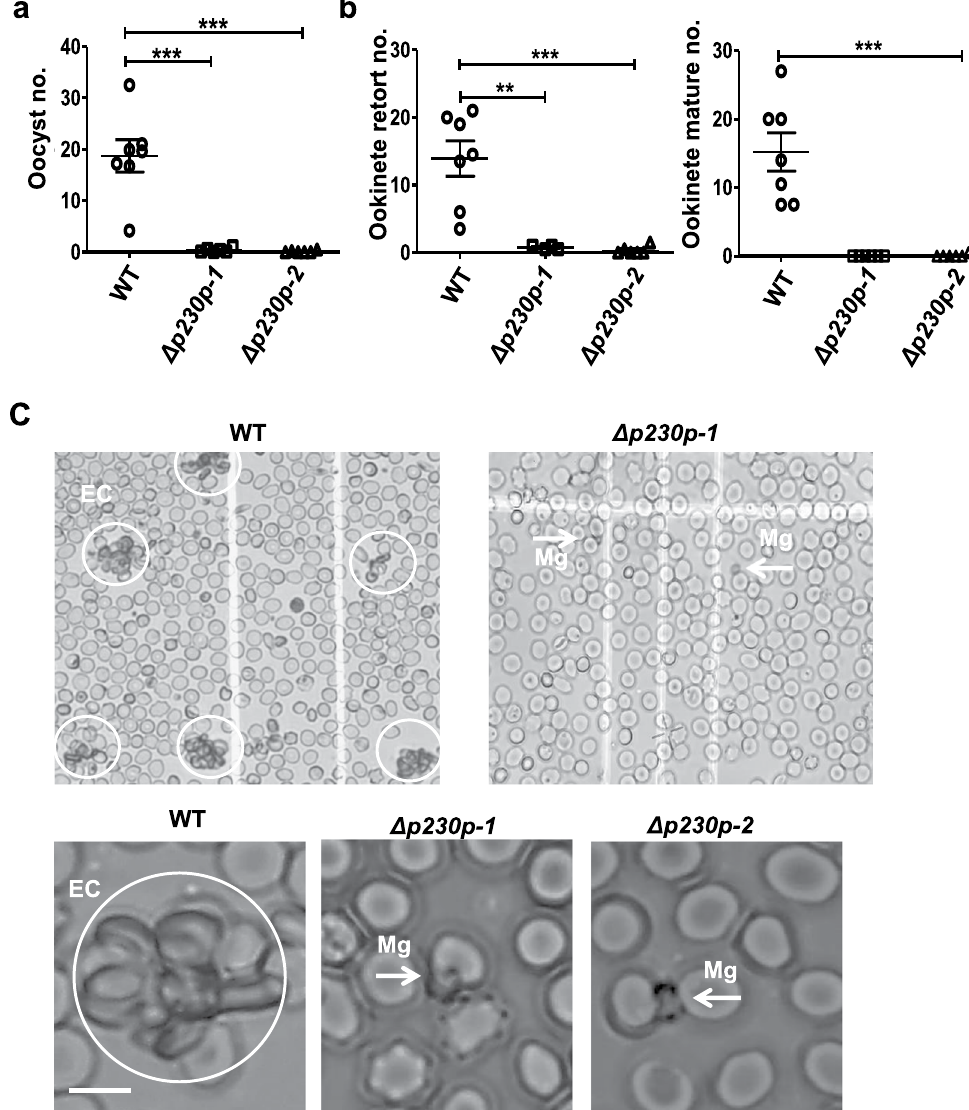
Figure 2. Mosquito development (ookinete and oocyst formation) and in vitro formation of exflagellation centres of Pf Δ p230p parasites. ( a ) Mean oocyst numbers in A . stephensi mosquitoes at day 8 after feeding in different experiments (exp.) with 10–20 mosquitoes/exp.: WT (7 exp.); Pf Δ p230p-1 (6 exp.); Pf Δ p230p-2 (6 exp.). *** p = 0.002 (unpaired T-test). ( b ) Mean ookinete numbers (retort and mature forms) in A . stephensi mosquitoes 24 hours after feeding. Left panel: retort (immature) ookinetes with 10–20 mosquitoes/exp.: WT (7 exp.); Pf Δ p230p-1 (4 exp.); Pf Δ p230p-2 (6 exp.). ** p = 0.005 and *** p = 0.0006 (unpaired T-test). Right panel: mature ookinetes with 10–20 mosquitoes/exp.: WT (7 exp.); Pf Δ p230p-1 (6 exp.); Pf Δ p230p-2 (6 exp.). *** p = 0.0004 (unpaired T-test). ( c ) Exflagellation centres (EC, circles) as observed by light microscopy analysis of live preparations of male gametocytes between 10 and 20 min after activation examined in a Bürker cell chamber. Only WT activated male gametocytes attach to red blood cells and form characteristic exflagellation centres (left panel; white circles). See also Supplementary Videos S1–6 for the absence/presence of exflagellation centres. Arrows indicate exflagellating male gametocytes (MG) of Pf Δ p230p . Scale bar, 7 µ